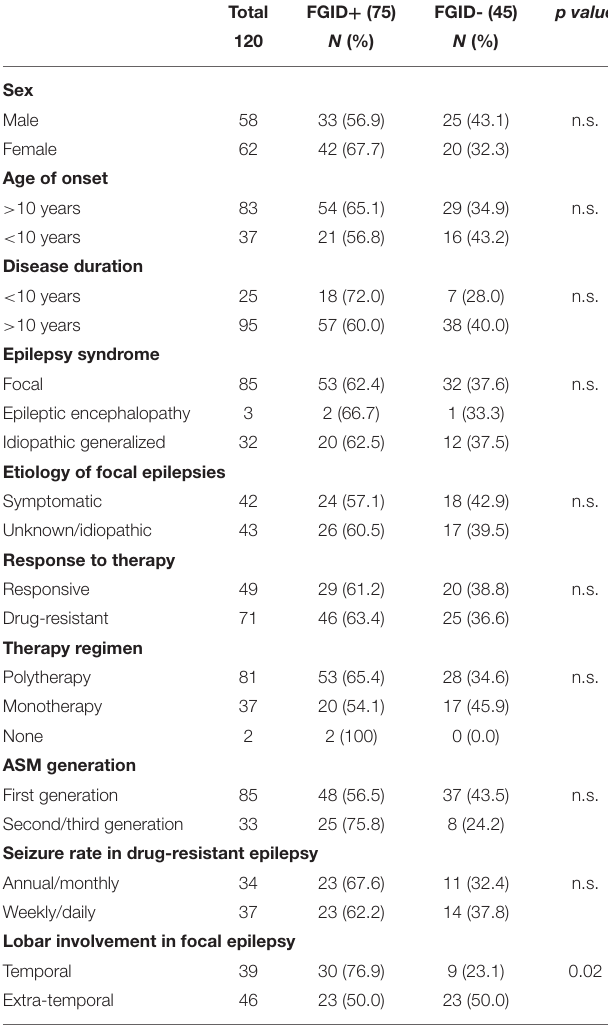
TABLE 3 | FGID according to demographic and clinical characteristics of the population.